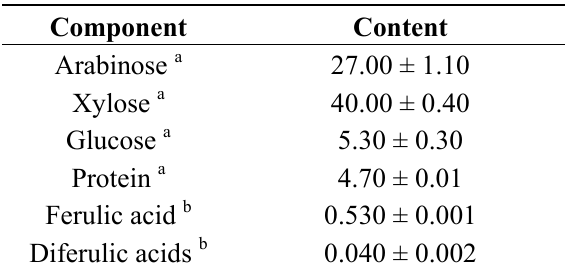
Table 1. Composition of